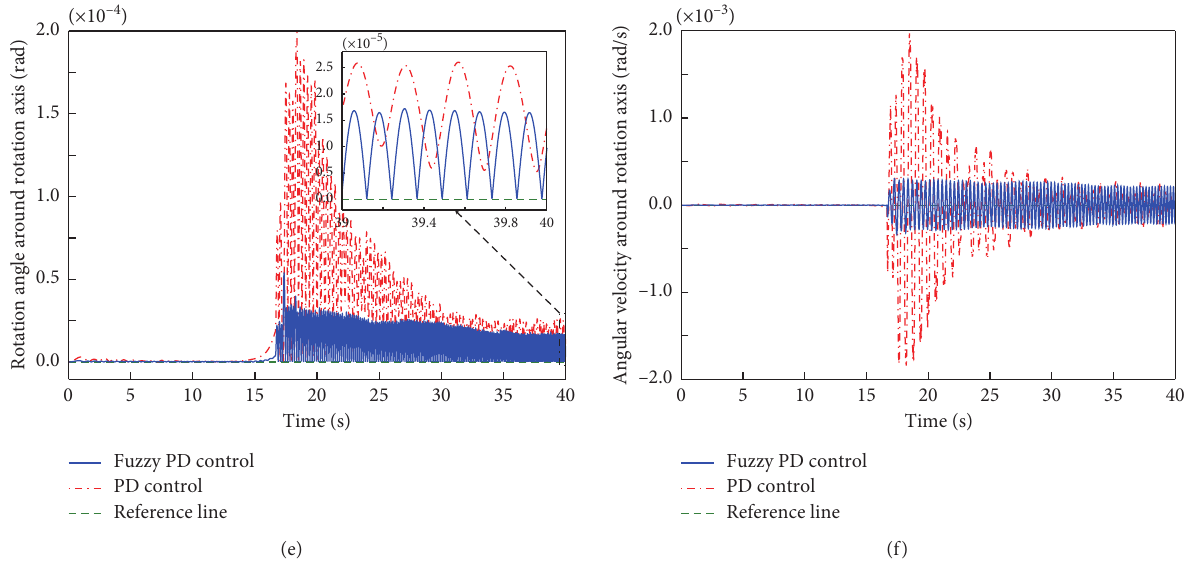
Figure 18: Comparisons of position and attitude responses between fuzzy PD control and conventional PD